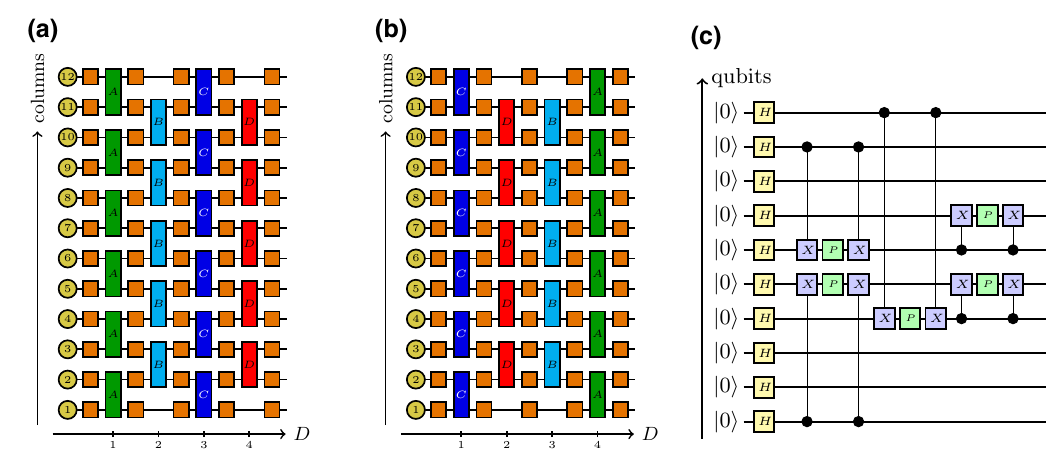
FIG. 6. The three sequences. Random quantum circuits defined by (a) sequence I and (b) sequence II. The circles represent columns of alternatively five and four qubits from the Sycamore chip, indexed from left to right. Orange squares correspond to applying a random one-qubit gate on each qubit (hence each column). Green, light blue, dark blue, and red rectangles correspond to applying two-qubit gates between all qubits coupled by the associated coupler, respectively A , B , C , and D . (c) Beginning of a ten-qubit circuit implementing the QAOA for a MaxCut problem (where P gates are parametrized phase shift